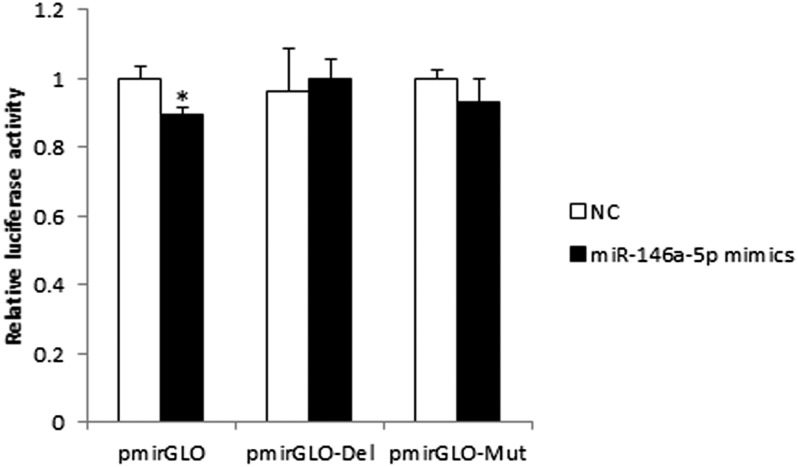
pmirGLO dual-luciferase reporter vectors analysis. CHO cells were transfected with each of the constructed plasmids, together with miR-146a-5p mimics/NC (* P < 0.05, n = 8). Relative luciferase activity was calculated by firefly luminescence/Renilla luminescence.